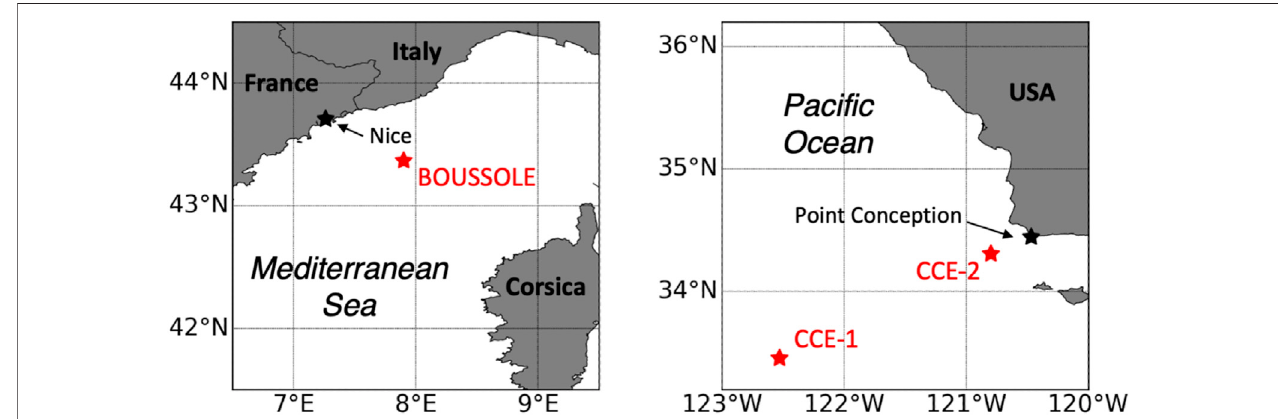
FIGURE 4 | Location of the three in situ sites (BOUSSOLE in the Western Mediterranean Sea and CCE-1 and -2 in the Northeast Paci fi c Ocean) used to evaluate EPIC < E PAR > estimates.